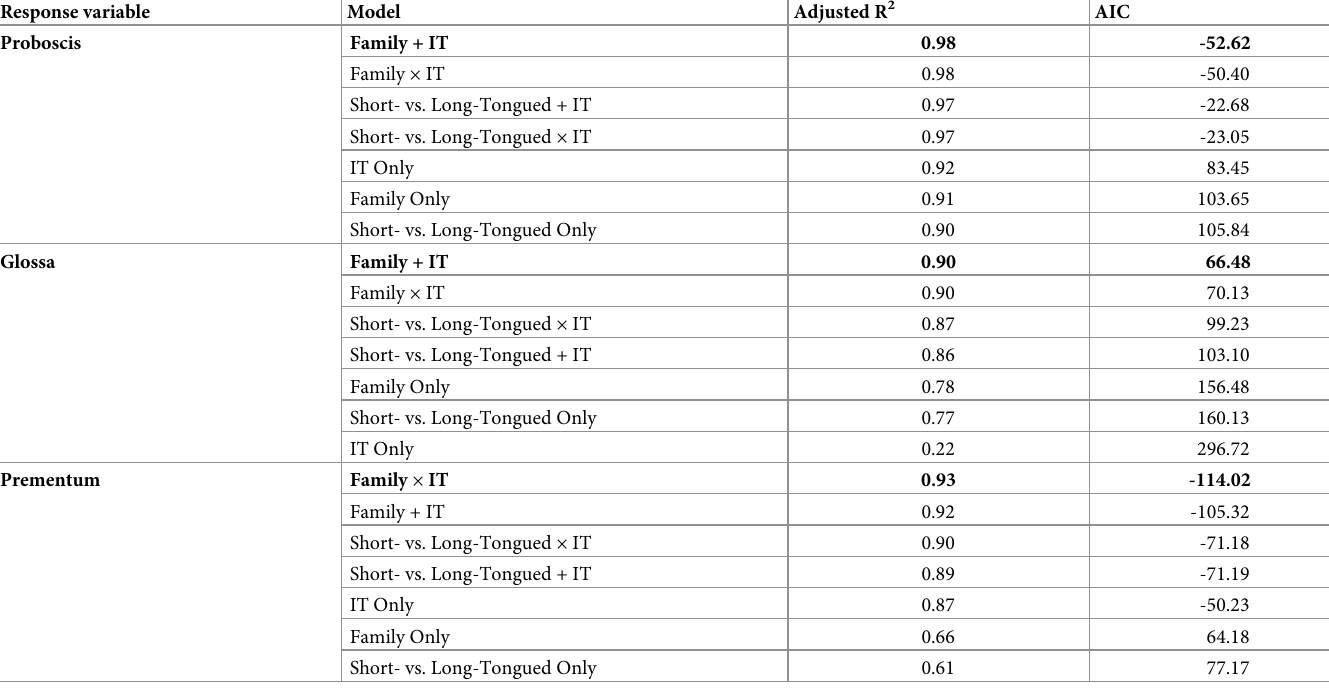
Table 1. Summary of model selection statistics for interspecific OLS regression models. Models are listed in order of increasing AIC value with the best model (lowest AIC) depicted in